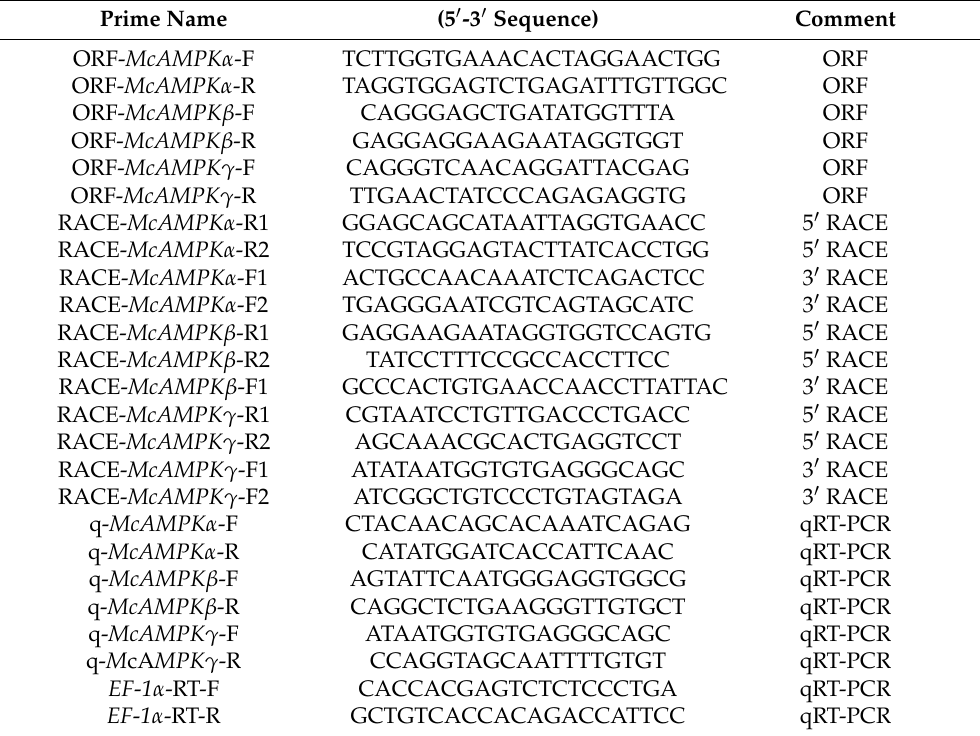
Table 1. The sequences of primers used in this